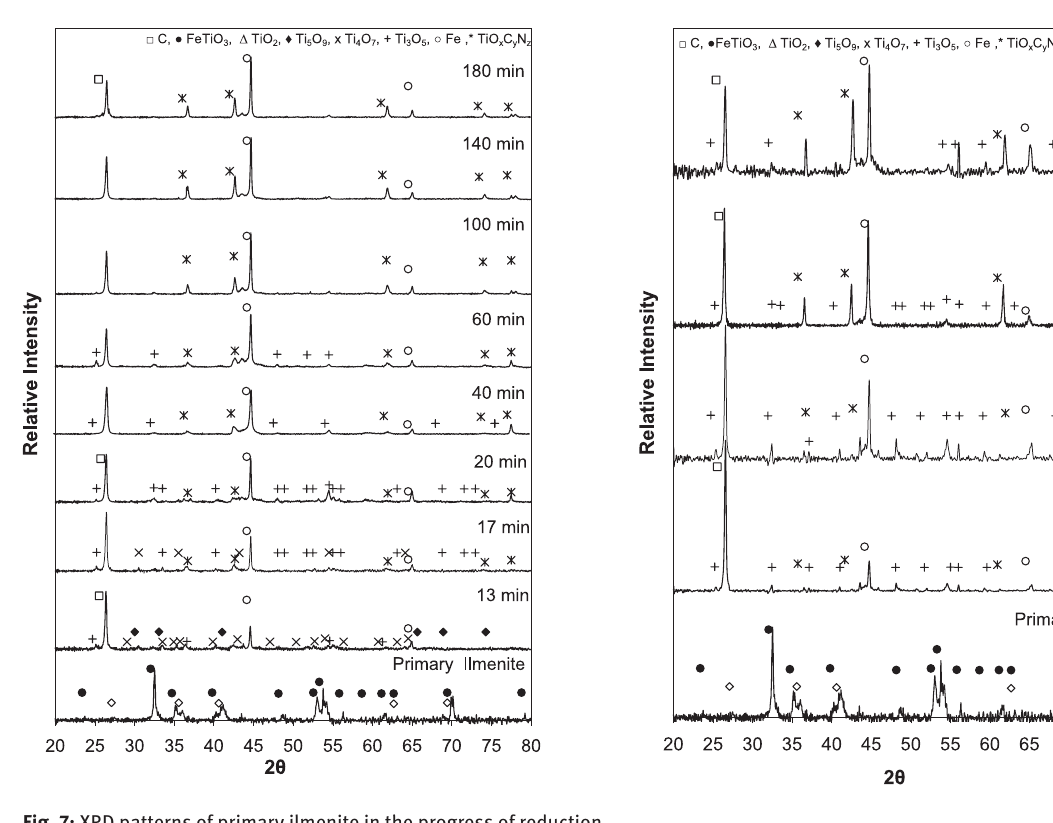
Fig. 8: XRD patterns of primary ilmenite in the progress of reduction in nitrogen at 1573